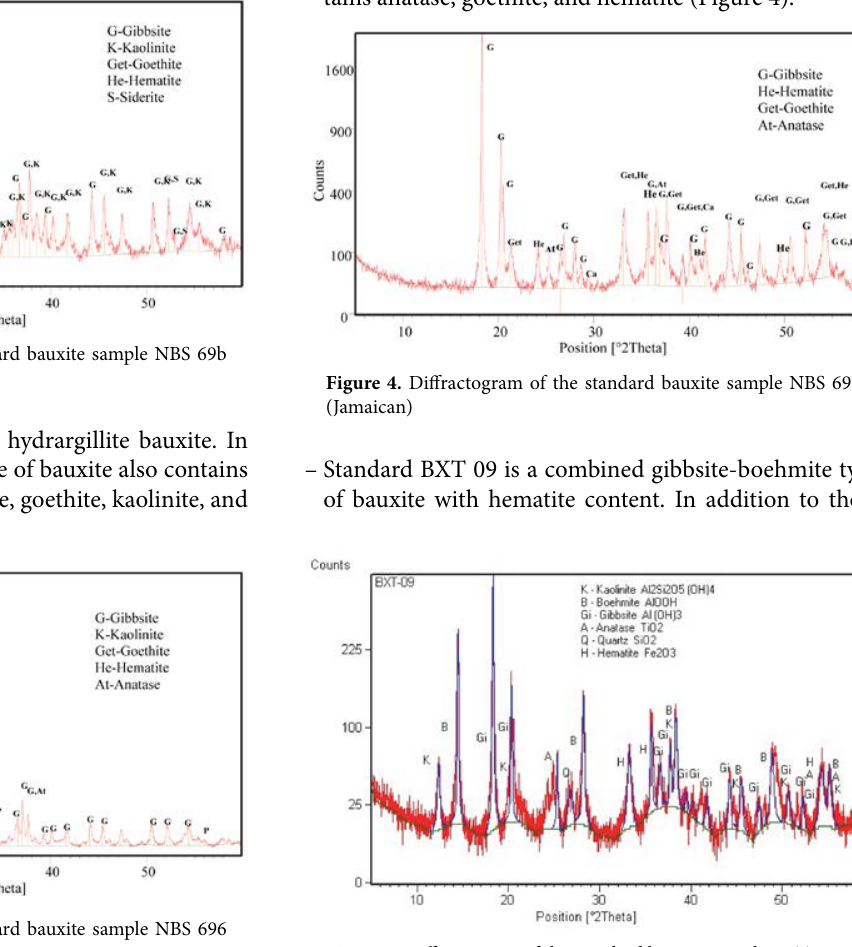
Figure 5. Diffractogram of the standard bauxite sample